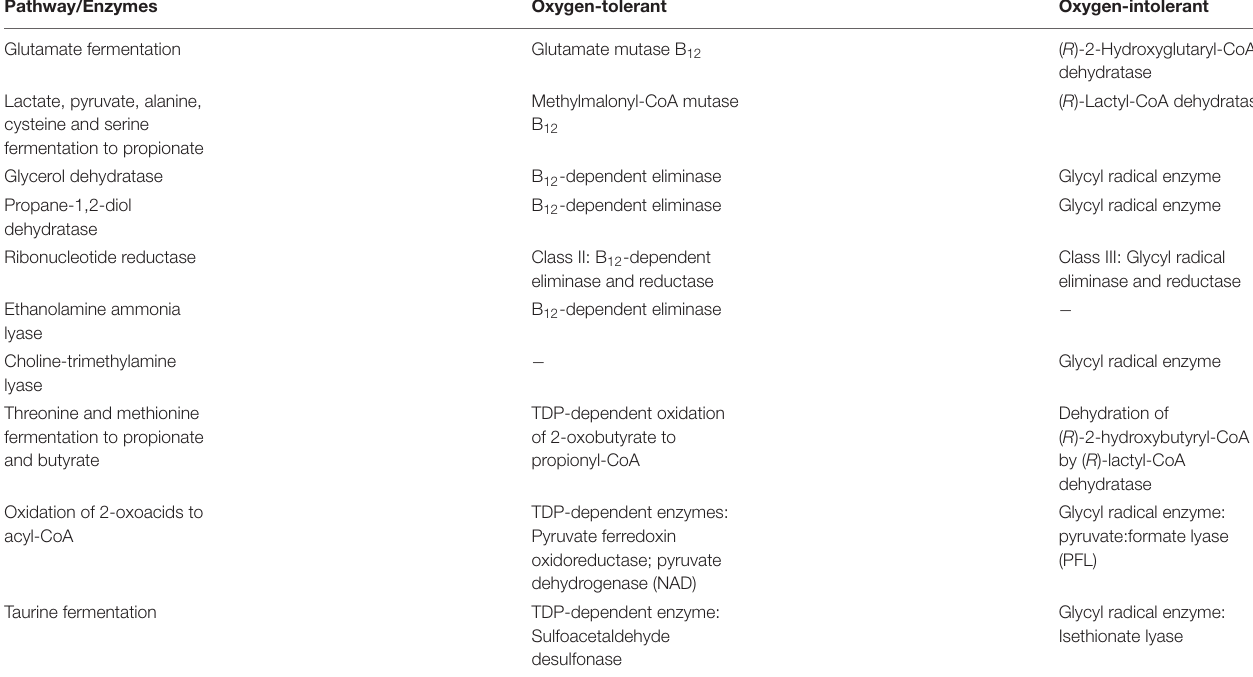
TABLE 2 | Pairs of oxygen-tolerant and intolerant enzymes which catalyze the same reaction or are key enzymes of alternative pathways leading to the same products.